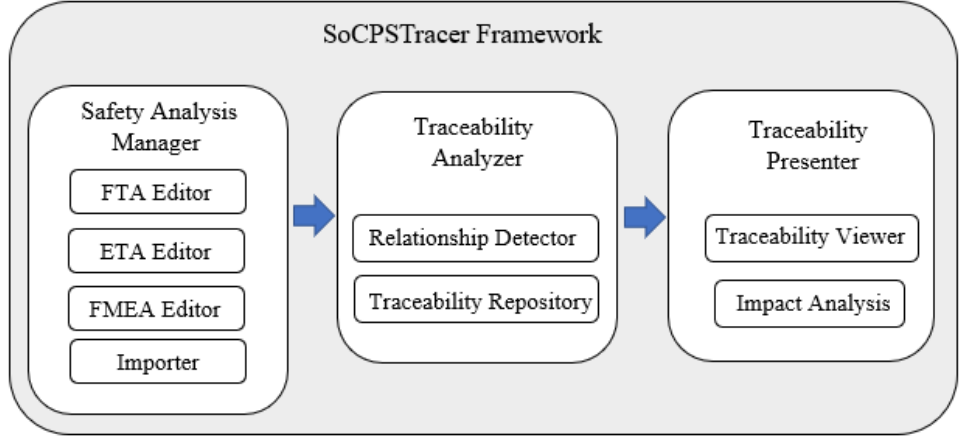
Figure 3. SoCPSTracer